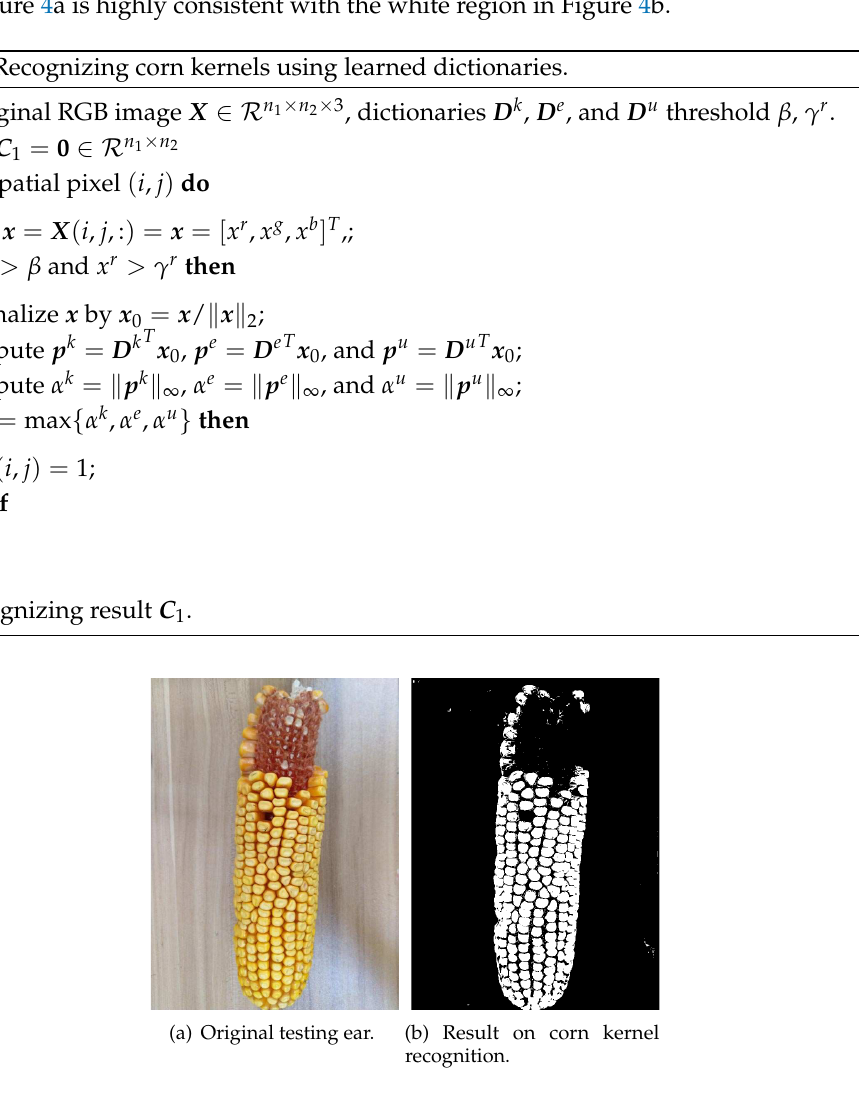
Figure 4. Corn kernel recognition for the testing ear using the proposed